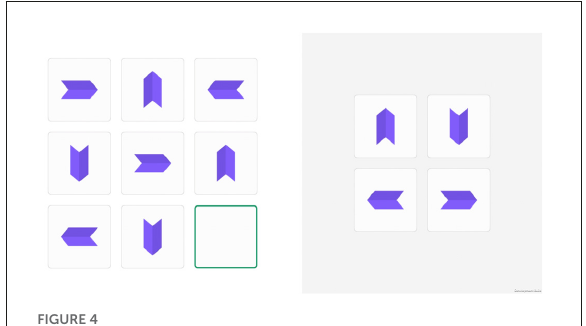
FIGURE4 Screenshot of the logic sequences task.